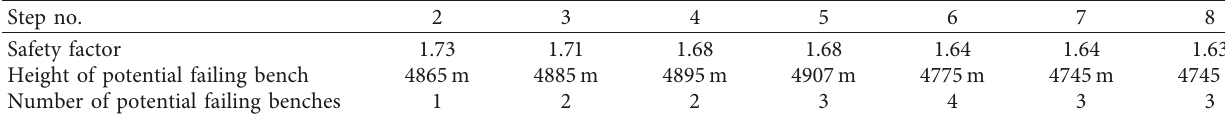
Table 11: FOS and number of potential failing bench at each step.